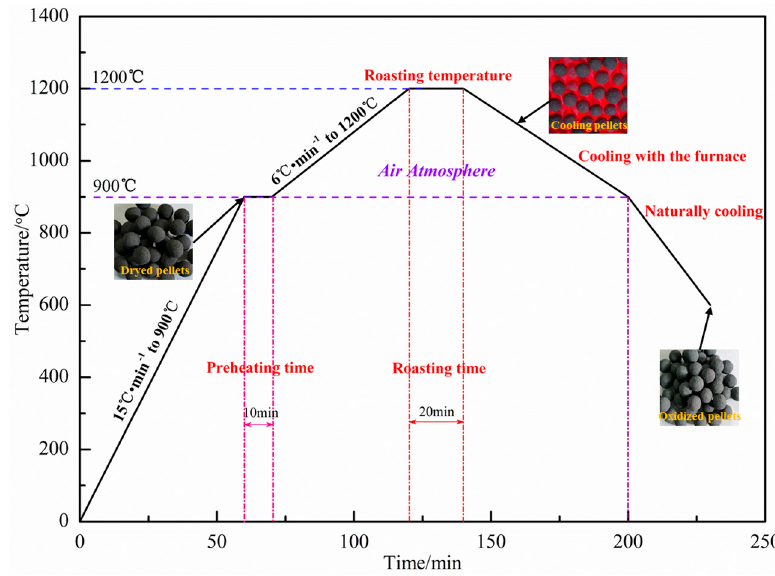
Figure 4. Roasting system of the green pellets.